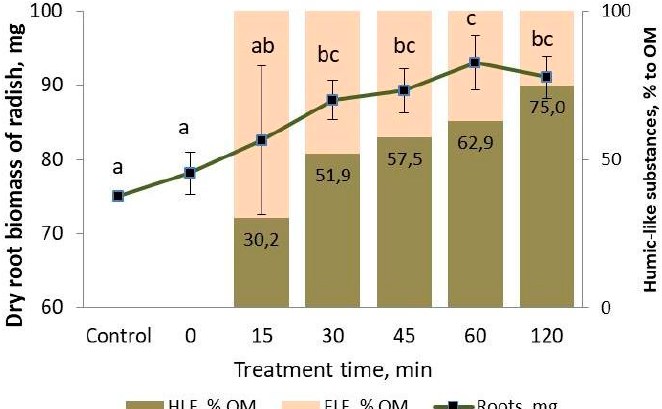
Figure 5. Dry root biomass of radish seedlings, treated with LH, sampled at different processing times (mean ± SD, n = 3). Different letters denote significant differences at the 0.05 confidence level between the treatments according to Fisher’s test.